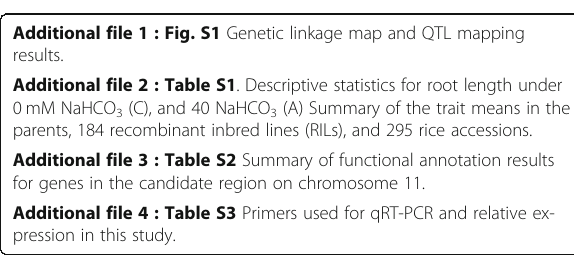
Additional file 1 : Fig. S1 Genetic linkage map and QTL mapping results. Additional file 2 : Table S1 . Descriptive statistics for root length under 0mM NaHCO 3 (C), and 40 NaHCO 3 (A) Summary of the trait means in the parents, 184 recombinant inbred lines (RILs), and 295 rice accessions. Additional file 3 : Table S2 Summary of functional annotation results for genes in the candidate region on chromosome 11. Additional file 4 : Table S3 Primers used for qRT-PCR and relative ex- pression in this